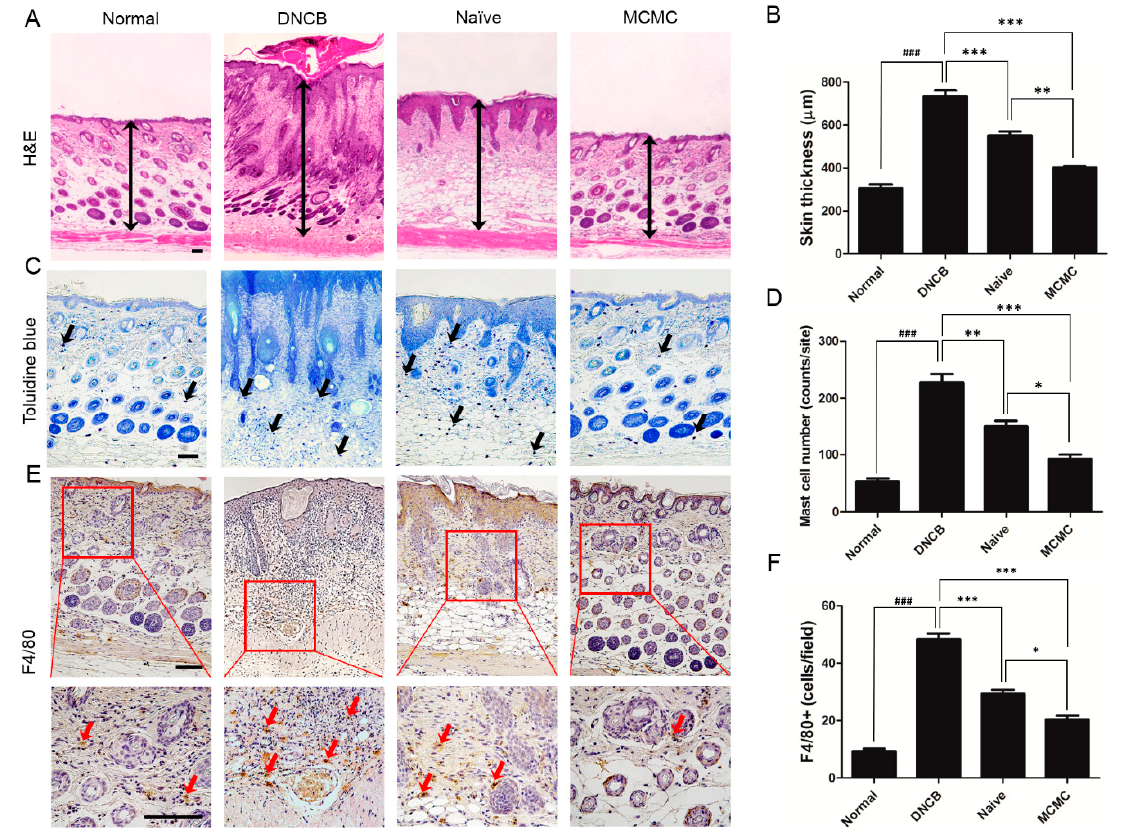
Figure 3. Histological analysis. E ff ects of MCMC on the histology of lesions in DNCB-treated mice. ( A ) Dorsal skin sections were stained with hematoxylin-eosin (H&E). Black up-down arrows indicate epidermal and dermal thickness. ( B ) The skin thickness was measured in H&E slides. ( C ) Mast cells were stained purple (black arrows) in toluidine blue-stained (TB) slides. ( D ) The number of mast cells was measured in TB slides. ( E ) Immunohistochemical (IHC) staining of F4 / 80 in mouse skins. Red boxes demonstrate the enlarged view and red arrows indicate dark brown dots as macrophages. ( F ) The number of macrophages was measured in IHC slides. The scale bar in Figure A is 100 µ m. The other scale bars are 500 µ m. Data are shown as mean ± SD (*, p < 0.05; **, p < 0.01; ***, p < 0.001; ###, p < 0.001).